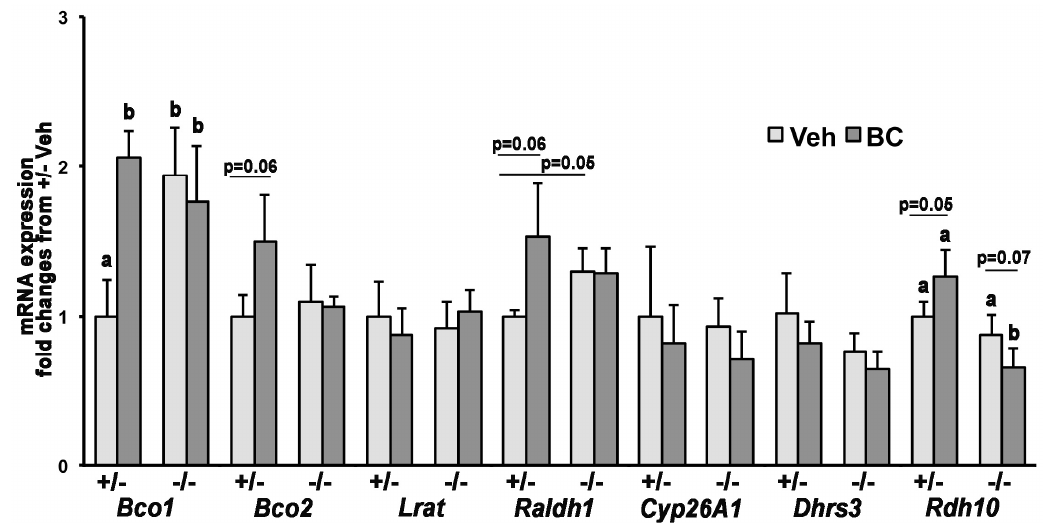
Figure 3. Hepatic mRNA expression of key genes of carotenoid and retinoid metabolism in Ldlr +/ − (+/ − ) and Ldlr − / − ( − / − ) pregnant mice administered β -carotene at 13.5 dpc. Analysis by qPCR. Data are presented as mean ± SD ( error bars ) of duplicate determinations and are representative of three independent determinations; n = 3 dams/group. Statistical analysis by ANOVA. Labeled means (within each gene) without a common letter differ, p < 0.05; borderline significant differences ( p < 0.1) between two groups are indicated and the respective p value is given.